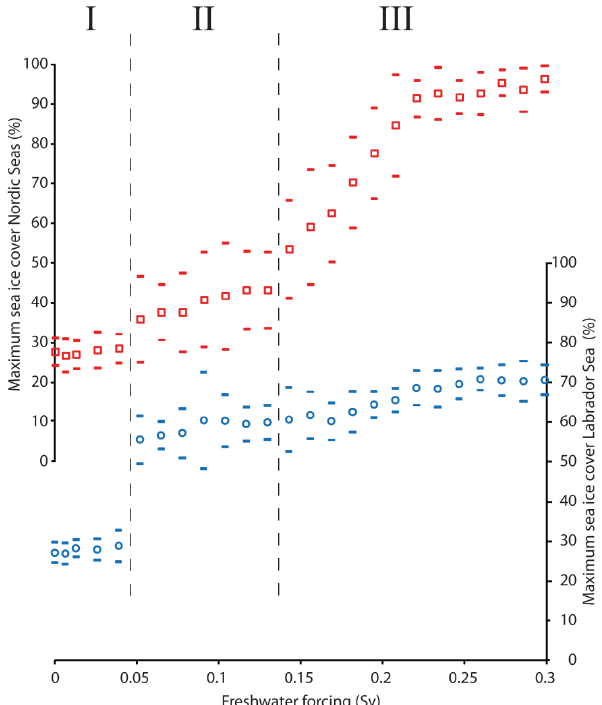
Fig. 2. Maximum (April) sea-ice cover (%) in the Labrador Sea (blue circles) and in the Nordic Seas (red squares) as a function of the melt rate of the GIS (Sv). Horizontal bars indicate the 95% confidence interval (2 σ ). Values are averages over the last 150yr of the simulations. The vertical dashed lines distinguish the three different climate regimes.